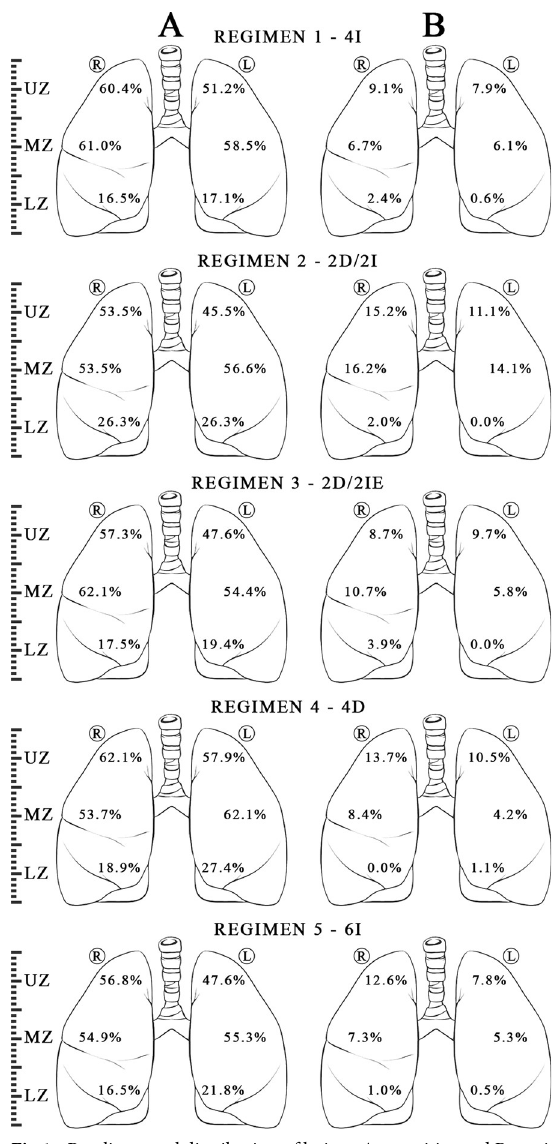
Fig 1. Baseline zonal distribution of lesions A -opacities and B- cavities (in percentages) shown regimen-wise. Ⓡ — Right Lung, Ⓛ –Left Lung. UZ—Upper Zone, MZ—Middle Zone, LZ—Lower Zone. Regimens - 4I - 4 months intermittent, 2D/2I - 2 months daily followed by 2 months intermittent, 2D/2IE—2 months daily followed by 2 months intermittent with ethambutol given in continuation phase also, 4D - 4 months daily, 6I - 6 months intermittent (Standard of care). All intermittent regimens were administered thrice weekly. Details of regimen provided in e- Supplement Section 1.1.